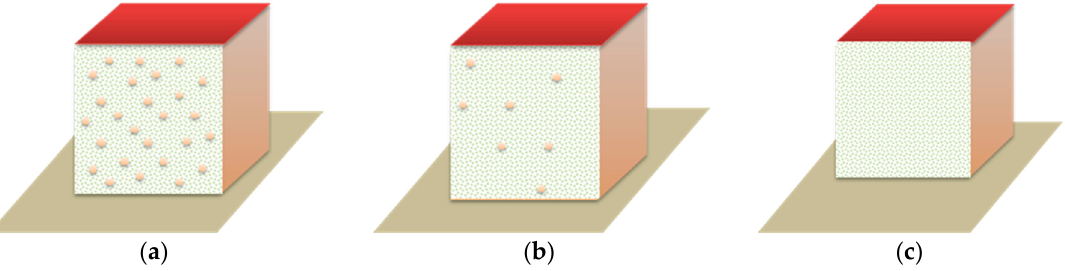
Figure 4. Points labelled as “unknown” for walls. ( a ) a wall scanned with dense points; ( b ) the same wall scanned with sparse or ( c ) no points in another epoch.